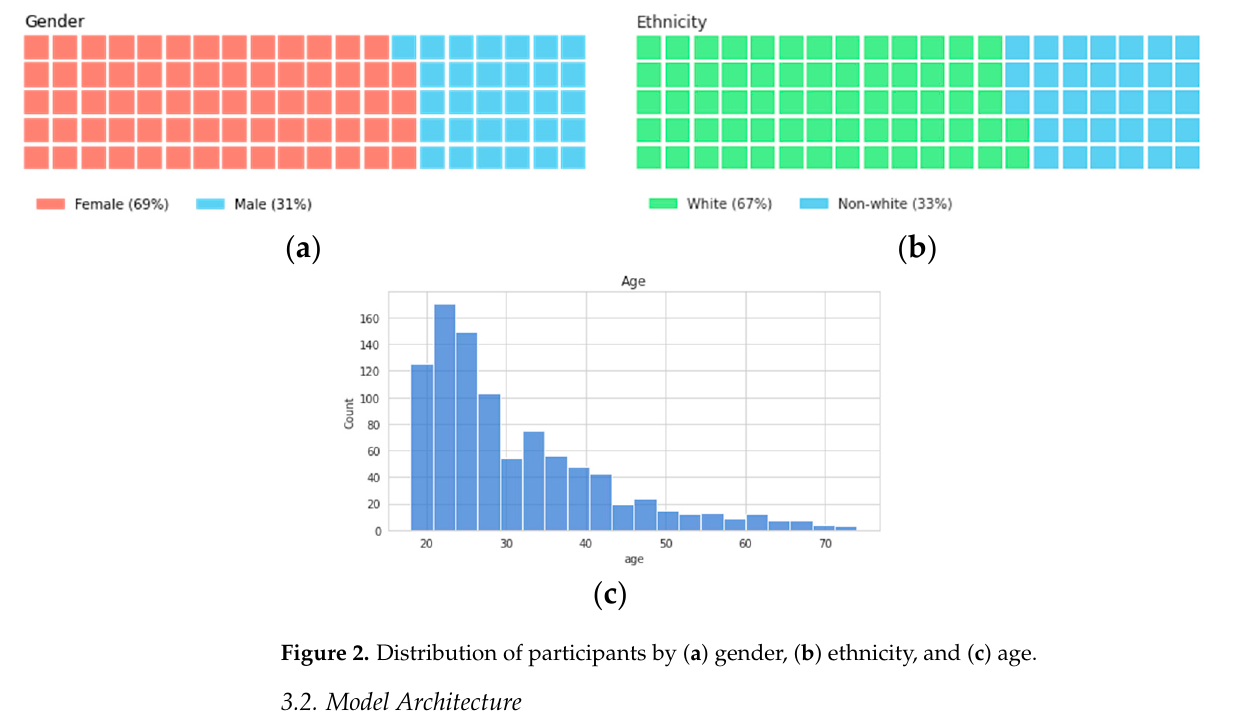
Figure 1. Distribution of scores for all participants included in the analysis: ( a ) PHQ-9 scores; ( b ) GAD-7 scores.